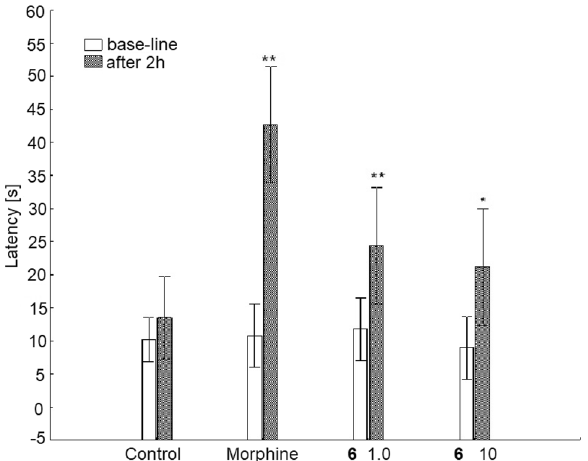
Figure 10. Influence of 6 and morphine on analgesic activity using tail-flick test. Values are mean ± SEM, 6 ( 6–1.0) a dose of 1.0 mg/kg, 6 ( 6–10) a dose of 10.0 mg/kg, **, * significant difference vs Control group; p < 0.05 or p < 0.1,